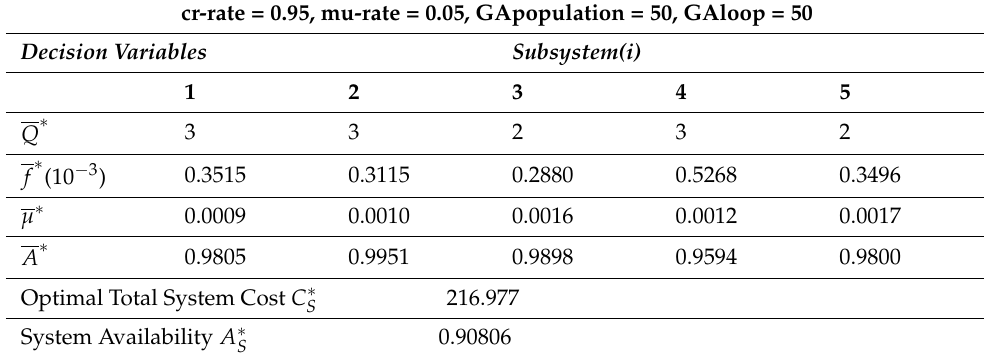
Table 44. Optimal Solutions obtained by mode 2 of MRAH–MGA for the for the n -stage mixed system. cr-rate = 0.95, mu-rate = 0.05, GApopulation = 50, GAloop = 50